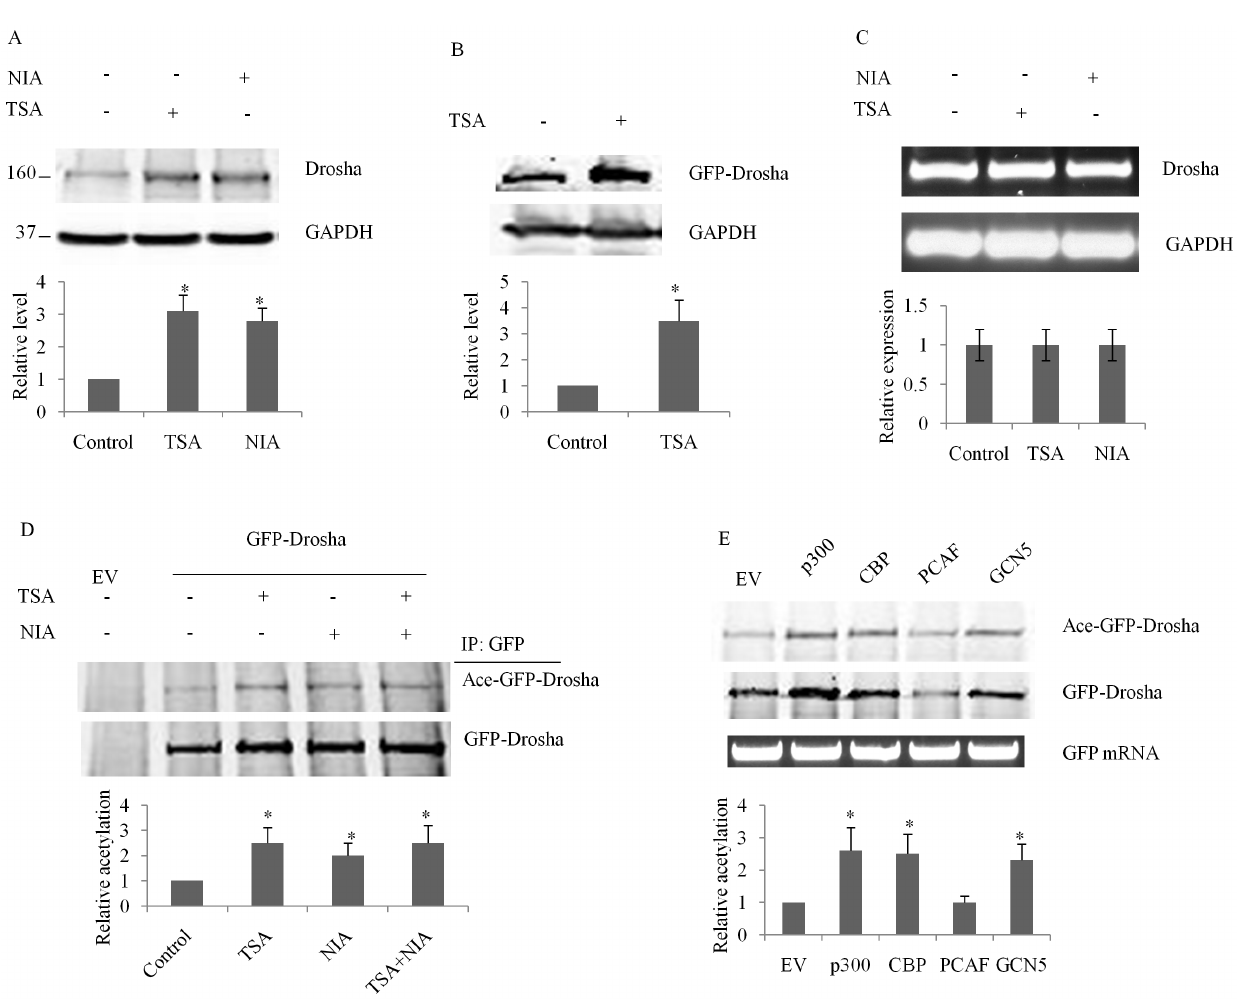
Figure 1. Acetylation of Drosha increases its protein level. All experiments were repeated three times with similar results (p , 0.05 by Student’s t-test). ( A ), Inhibition of deacetylases increases Drosha protein level measured by western blot. HEK293T cells were treated with vehicle, trichostatin A (TSA, 2 m M), or nicotinamide (NIA, 1 mM) overnight prior to harvest. ( B ) TSA, an HDAC inhibitor, increases ectopically expressed Drosha levels in HEK293T upon transfection with a GFP-Drosha construct. ( C ) Inhibition of deacetylases have no effects on Drosha mRNA level measured